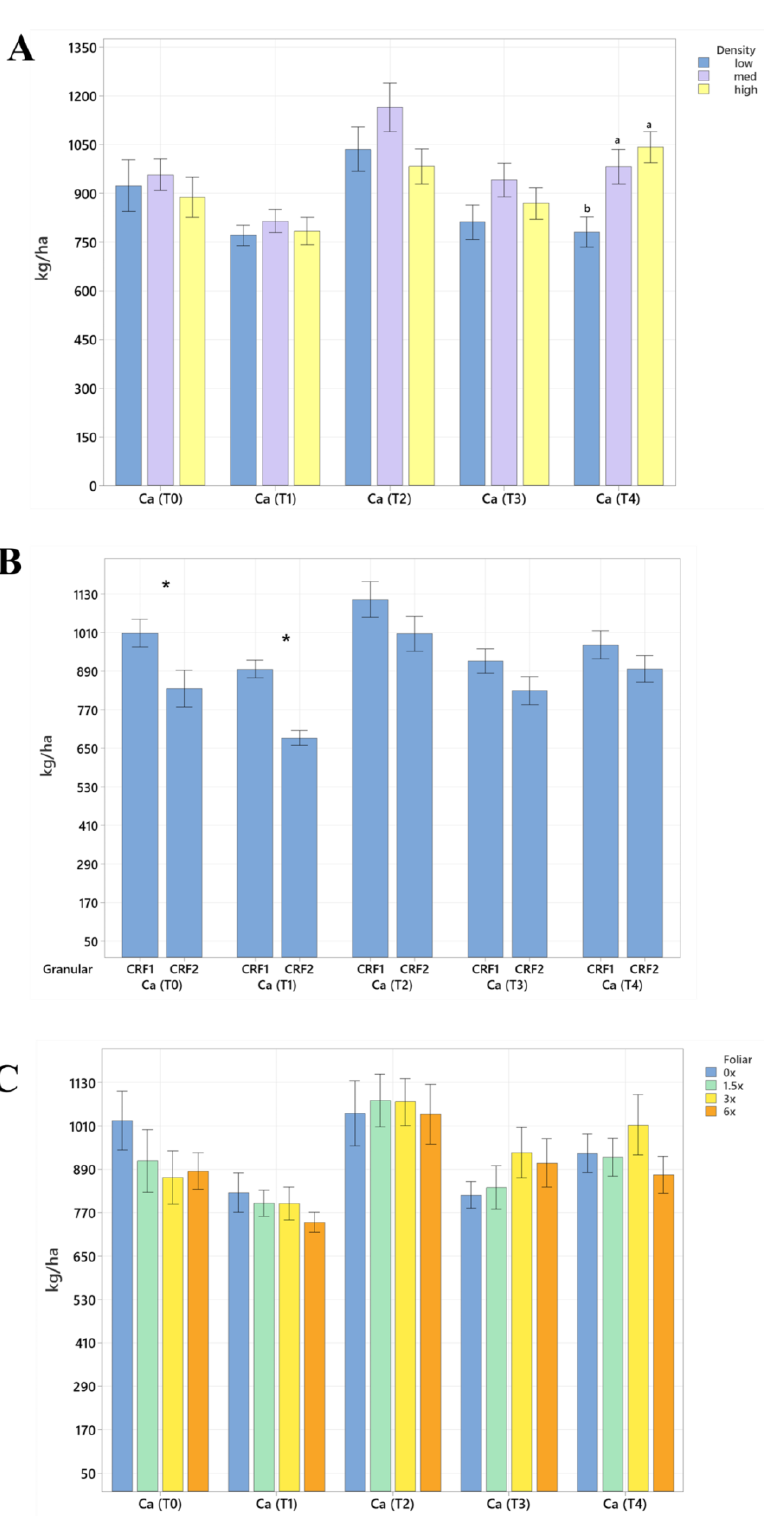
Figure 2. Soil Ca concentrations of ‘Ray Ruby’ grapefruit grafted on ‘Kuharske’ citrange planted in flatwood soils located in Fort Pierce, FL, USA, in response to ( A ) planting density, ( B ) ground-applied fertilizer and ( C ) foliar fertilizer treatments during September 2020 (T0), January 2021 (T1), May 2021 (T2), September 2021 (T3) and January 2022 (T4). Bars are ± standard deviation of the mean. Treatments with * and different letters were considered to be significantly different ( p < 0.05).